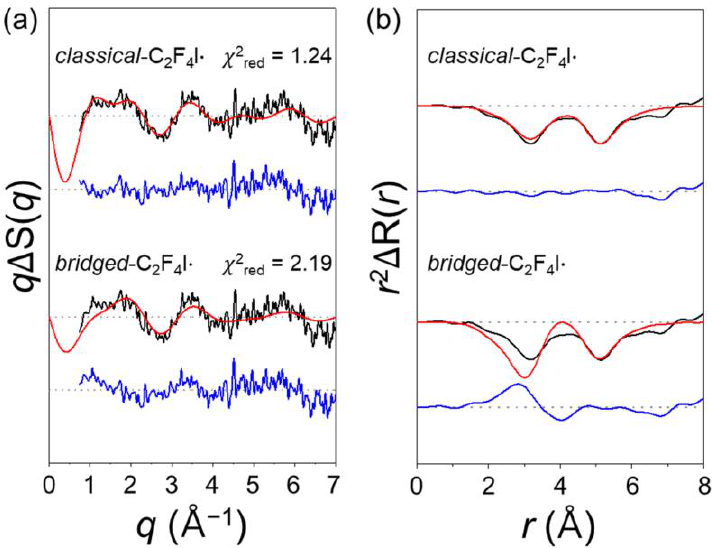
Figure 3. Comparison of models using only either classical (top) or bridged (bottom) structure of C 2 F 4 I · radical. The contribution only associated with the formation of C 2 F 4 I · radical (C 2 F 4 I 2 → C 2 F 4 I · + I · ) was extracted from experimental data at 100 ps (and its theoretical fit) by subtracting the cage and solvent terms, and the contribution of other solute species. The extracted experimental (black) and theoretical (red) scattering curves for the formation of C 2 F 4 I · only are compared in the ( a ) q -space and ( b ) r -space. Blue curve represents the obtained residual by subtracting the theoretical curve from the experimental curve. The reduced chi-squared value for each fit is shown above the experimental and theoretical curves. The classical structure gave a much better fit than the bridged structure